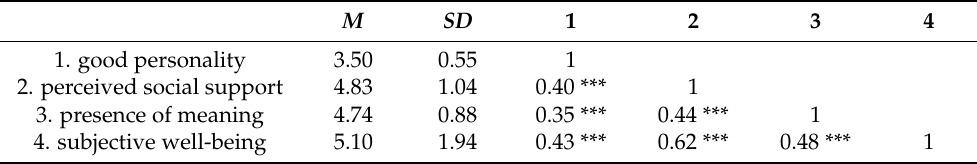
Table 3. Means, SD, and correlations for the main study variables (N = 665).